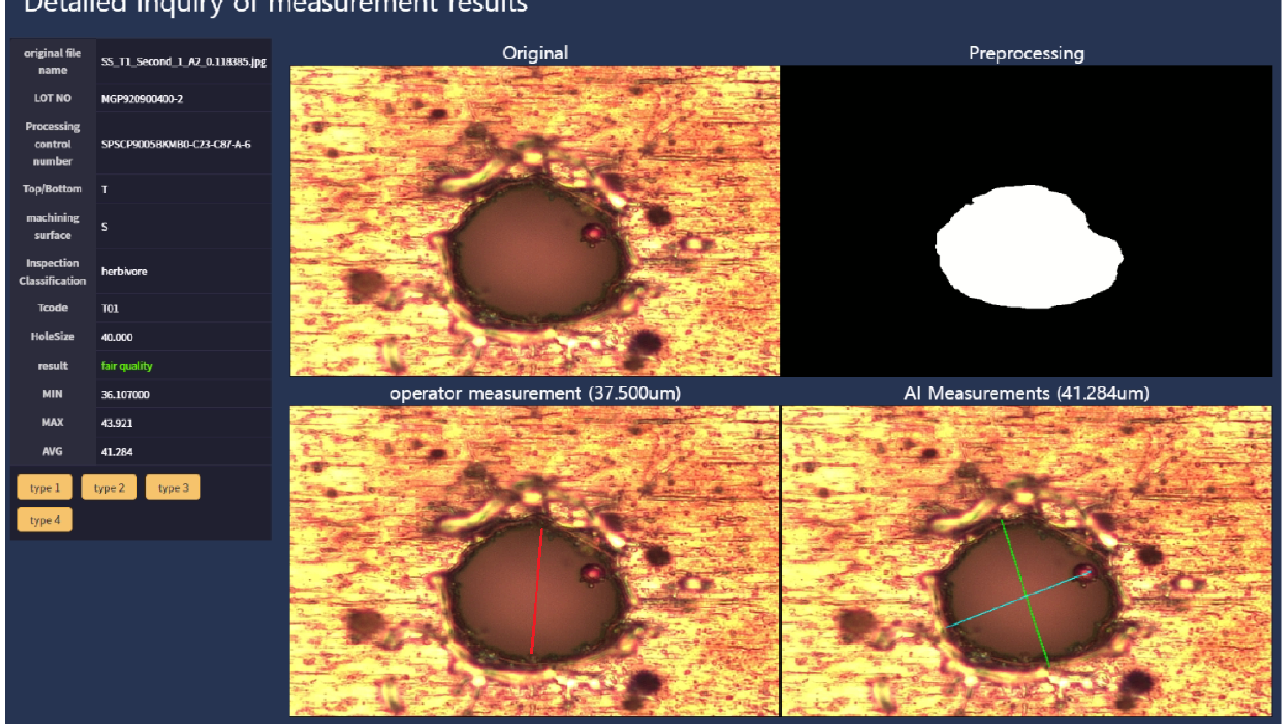
Figure 18. Information about an example hole that was measured using the AI method.